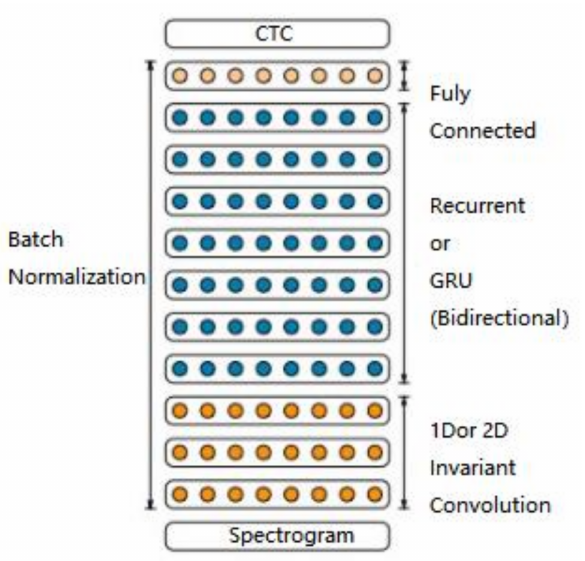
Figure 7. Architecture of the DS2 system used to train on both English and Mandarin speech. We explore variants of this architecture by varying the number of convolutional layers from 1 to 3 and the number of recurrent or GRU layers from 1 to 7